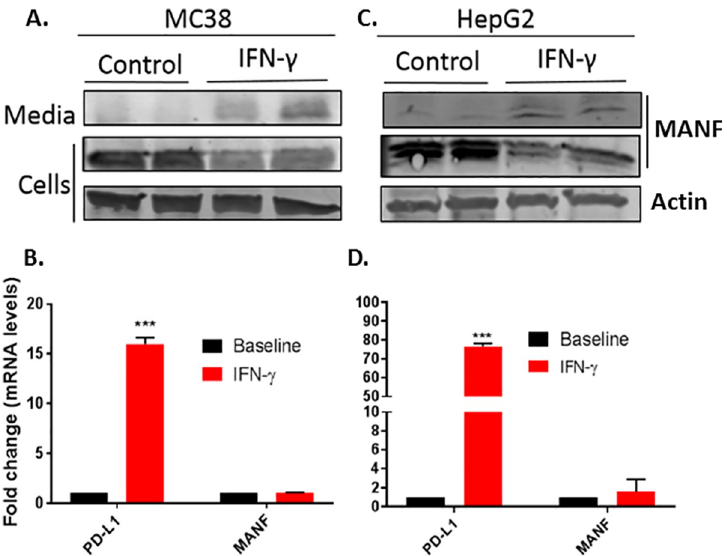
Fig 2. IFN- γ induces MANF secretion in additional cell-lines. MC38 ( A and B ) and HepG2 ( C and D ) cell-lines were treated with 100 ng/ml IFN- γ for 48 hours, followed by immunoblot analysis of the cells lysates and media (upper panels) or RT-PCR analysis of MANF and PD-L1 (lower panels). RNA expression is relative to baseline. N = 3, data is represented as mean ± SEM. ��� p-value < 0.001.